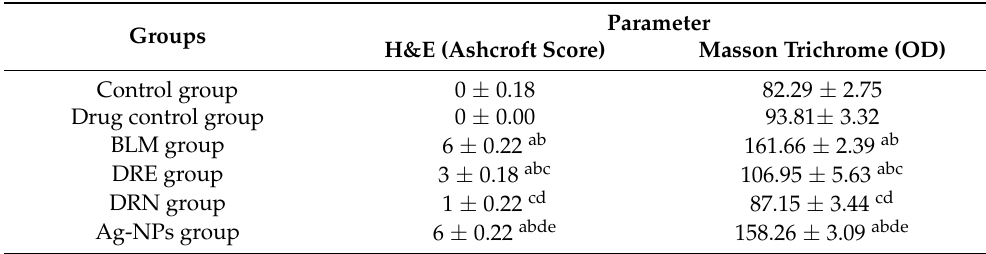
Table 1. Effect of DRE and DRN on lung histopathology scoring and collagen deposition in BLM male Swiss albino rats.